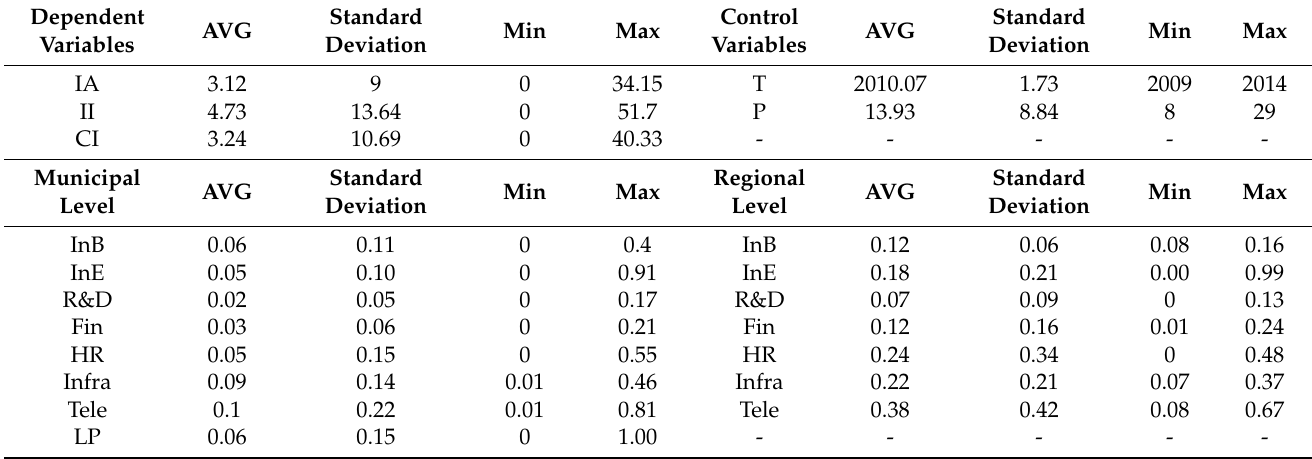
Table 3. Description of the